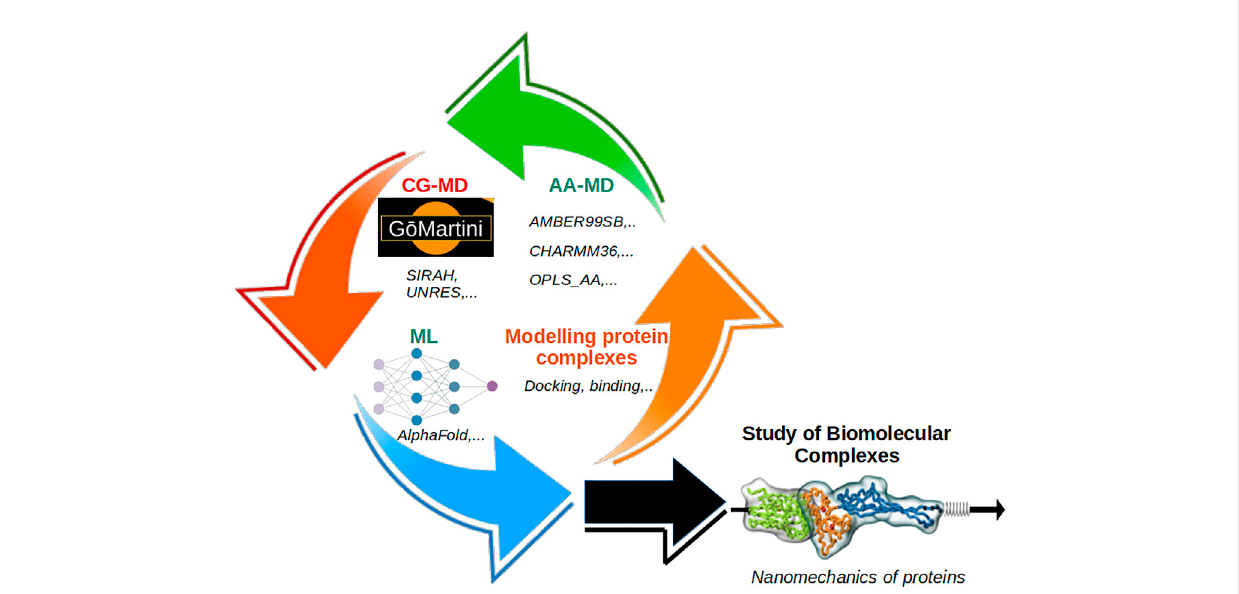
FIGURE 1 Schematic description of the integration of different methodologies employed in the study of biomolecular complexes: i) all-atom MD, ii) coarse- grained MD,iii)machine learning,andiv)modeling tools.Togethertheycan copewiththestudyofcomplexmolecular systems, suchas biomechanics of protein complexes and other systems at the cellular